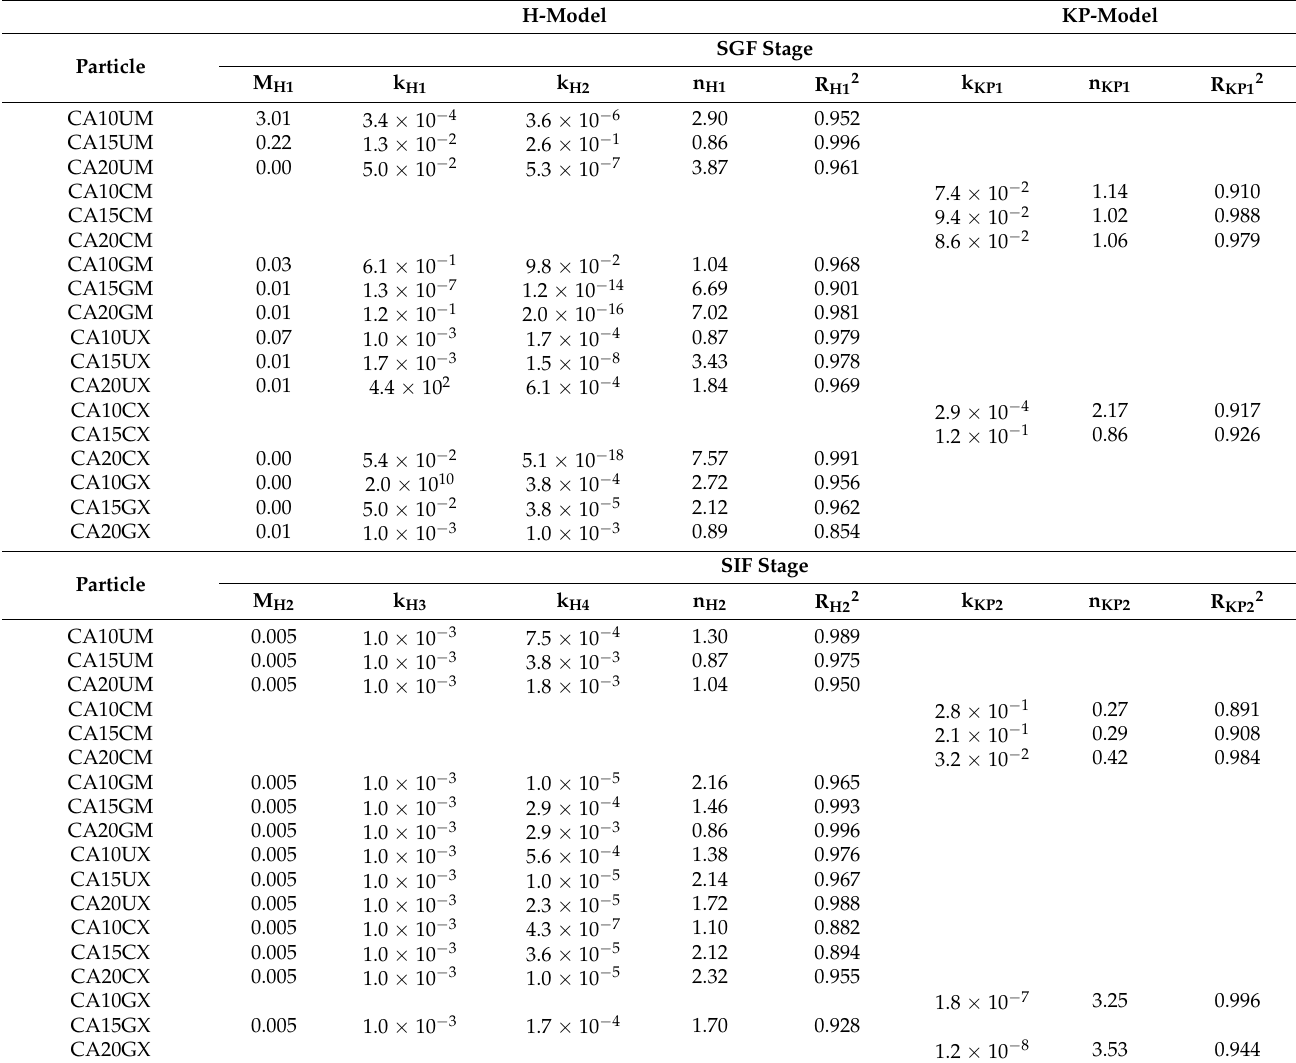
Table 2. Kinetic parameters of hybrid (H) and Korsmeyer–Peppas (KP) models estimated from the fitting to experimental data received during the simulated gastric fluid (SGF), simulated intestine fluid (SIF), and simulated colon fluid (SCF) stages of CUR in vitro release. Bold type indicates the best fit. For details of the particle composition, see Table 1. For a detailed description of the kinetic parameters, see Section